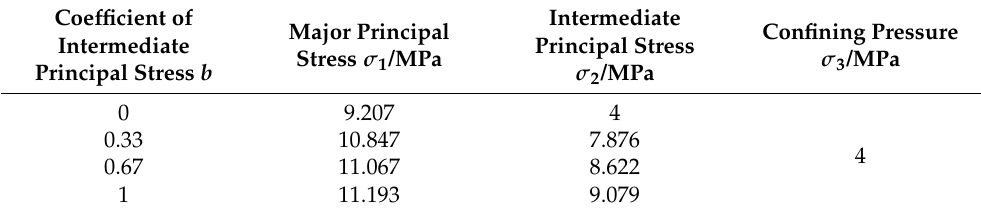
Table 7. Corresponding stress values with different middle principal stress